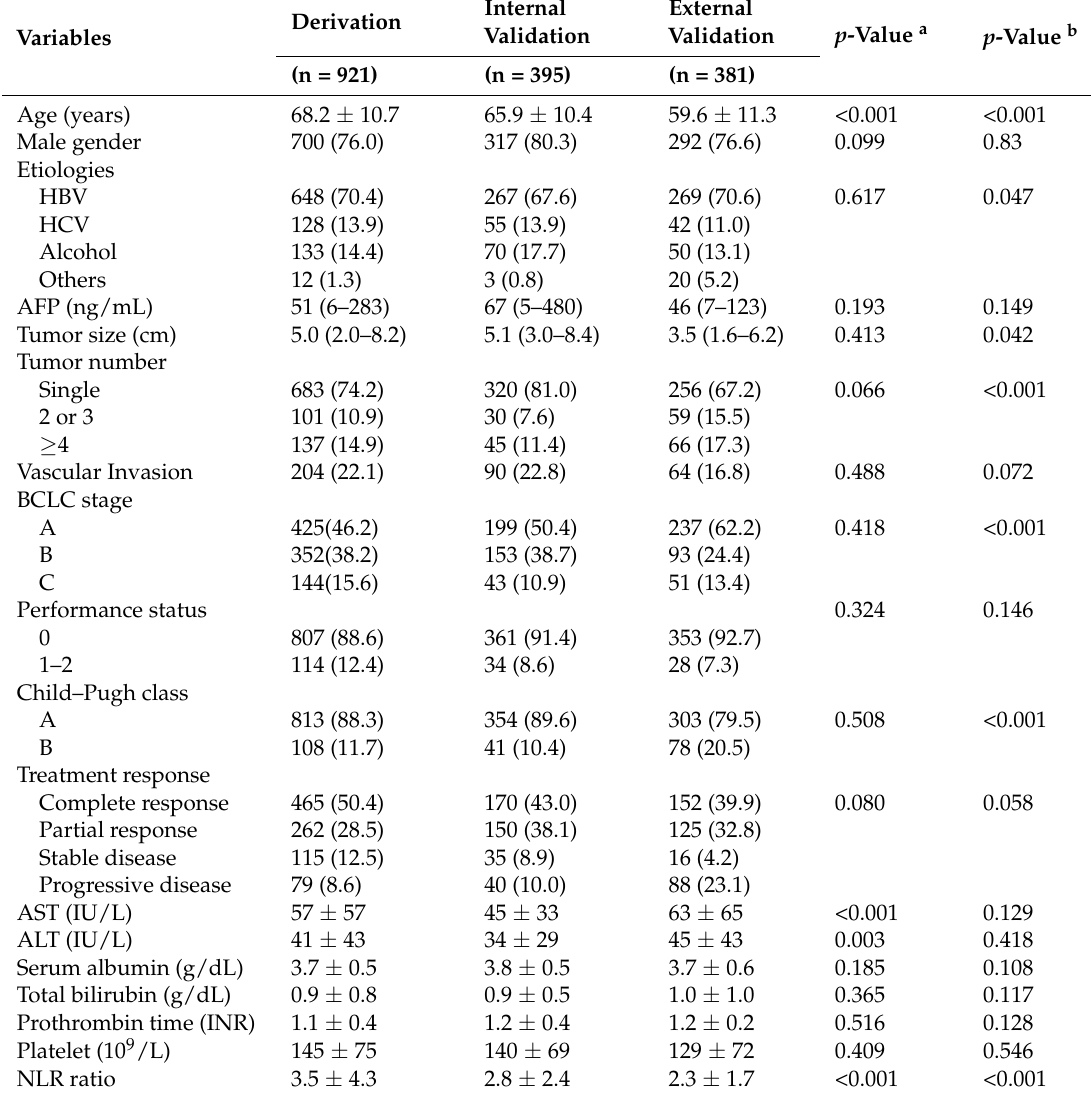
Table 1. Baseline characteristics of study